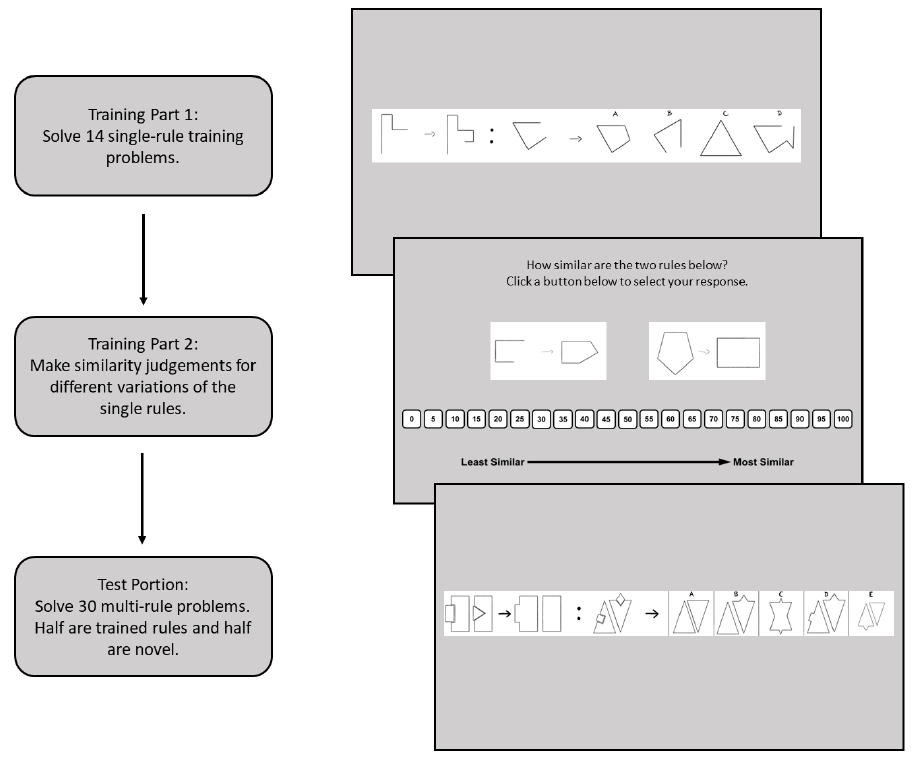
Figure 2. Diagram of figural analogy procedure.